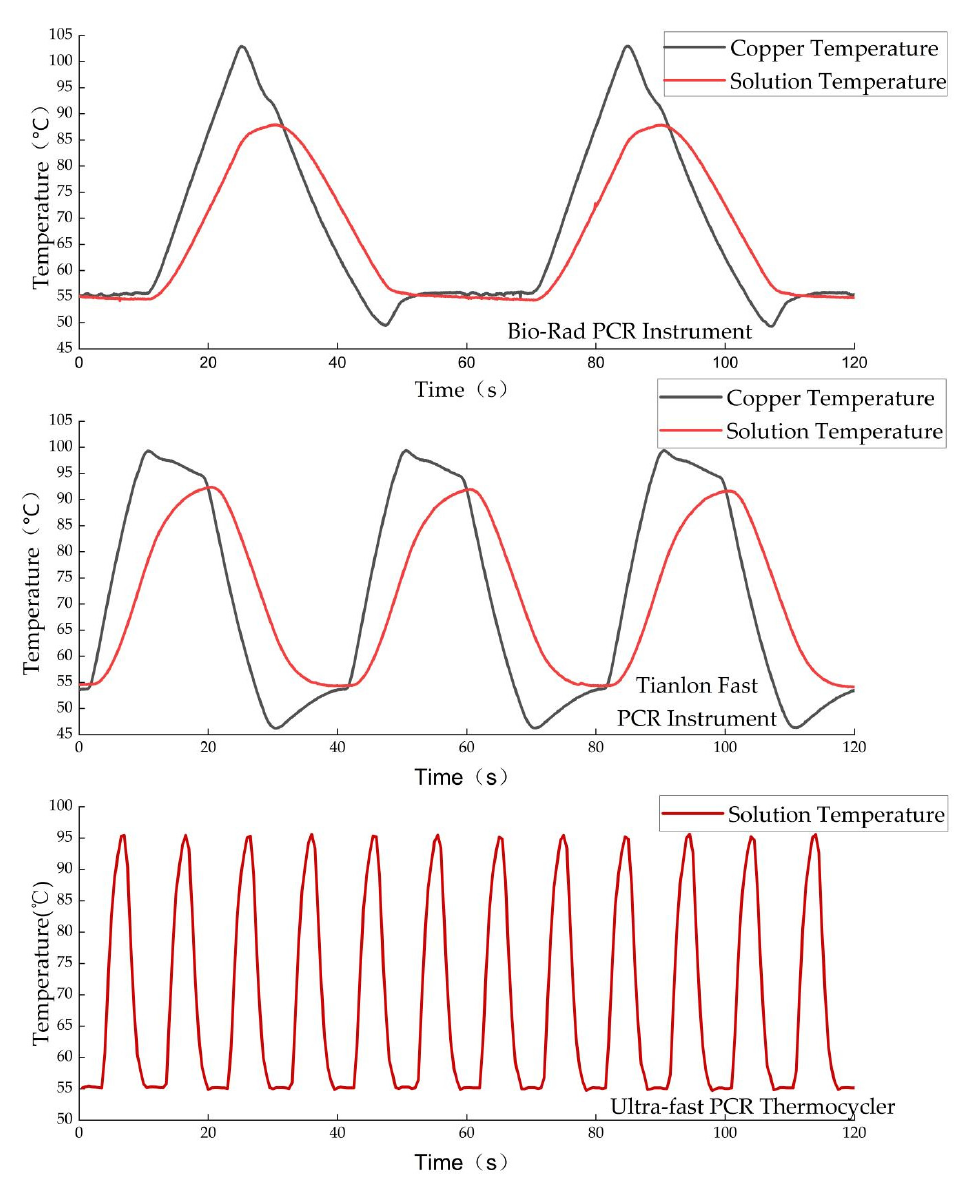
Figure 11. Comparison of solution temperatures between 55 °C and 95 °C for three PCR devices.